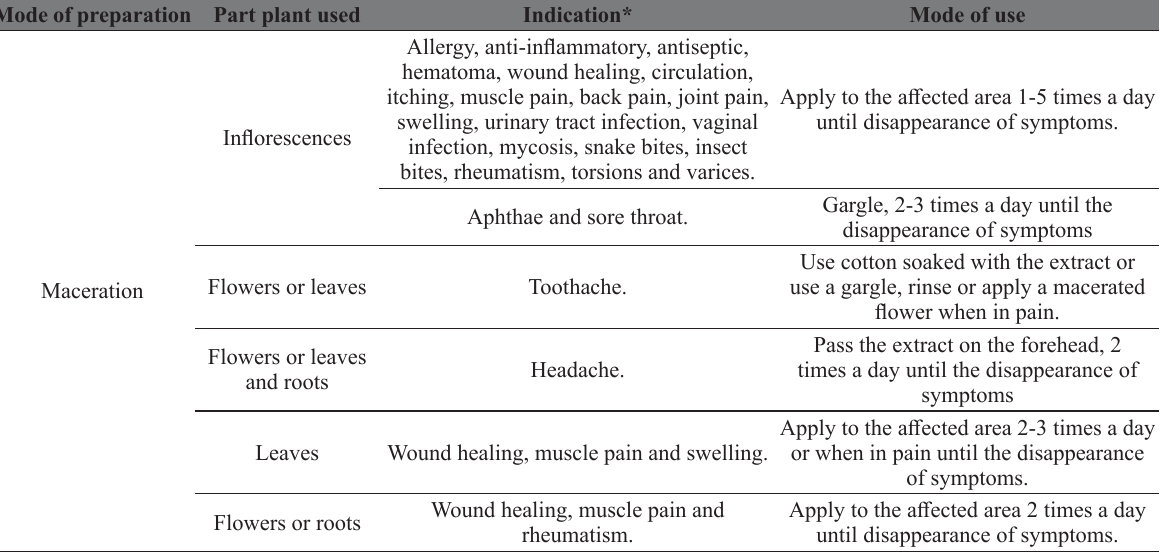
indications for popular use with topical C. uniflora . mode of preparation Part plant